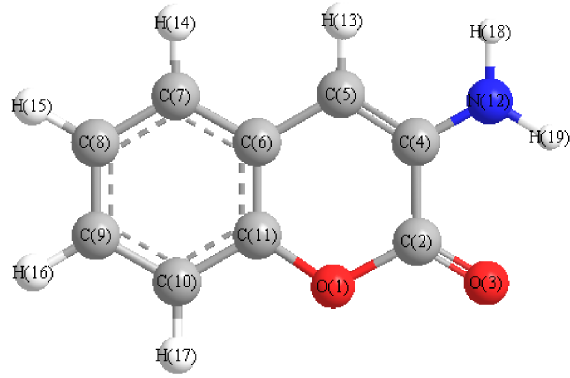
Figure 2. The 3d structure of 3-aminocoumarin.